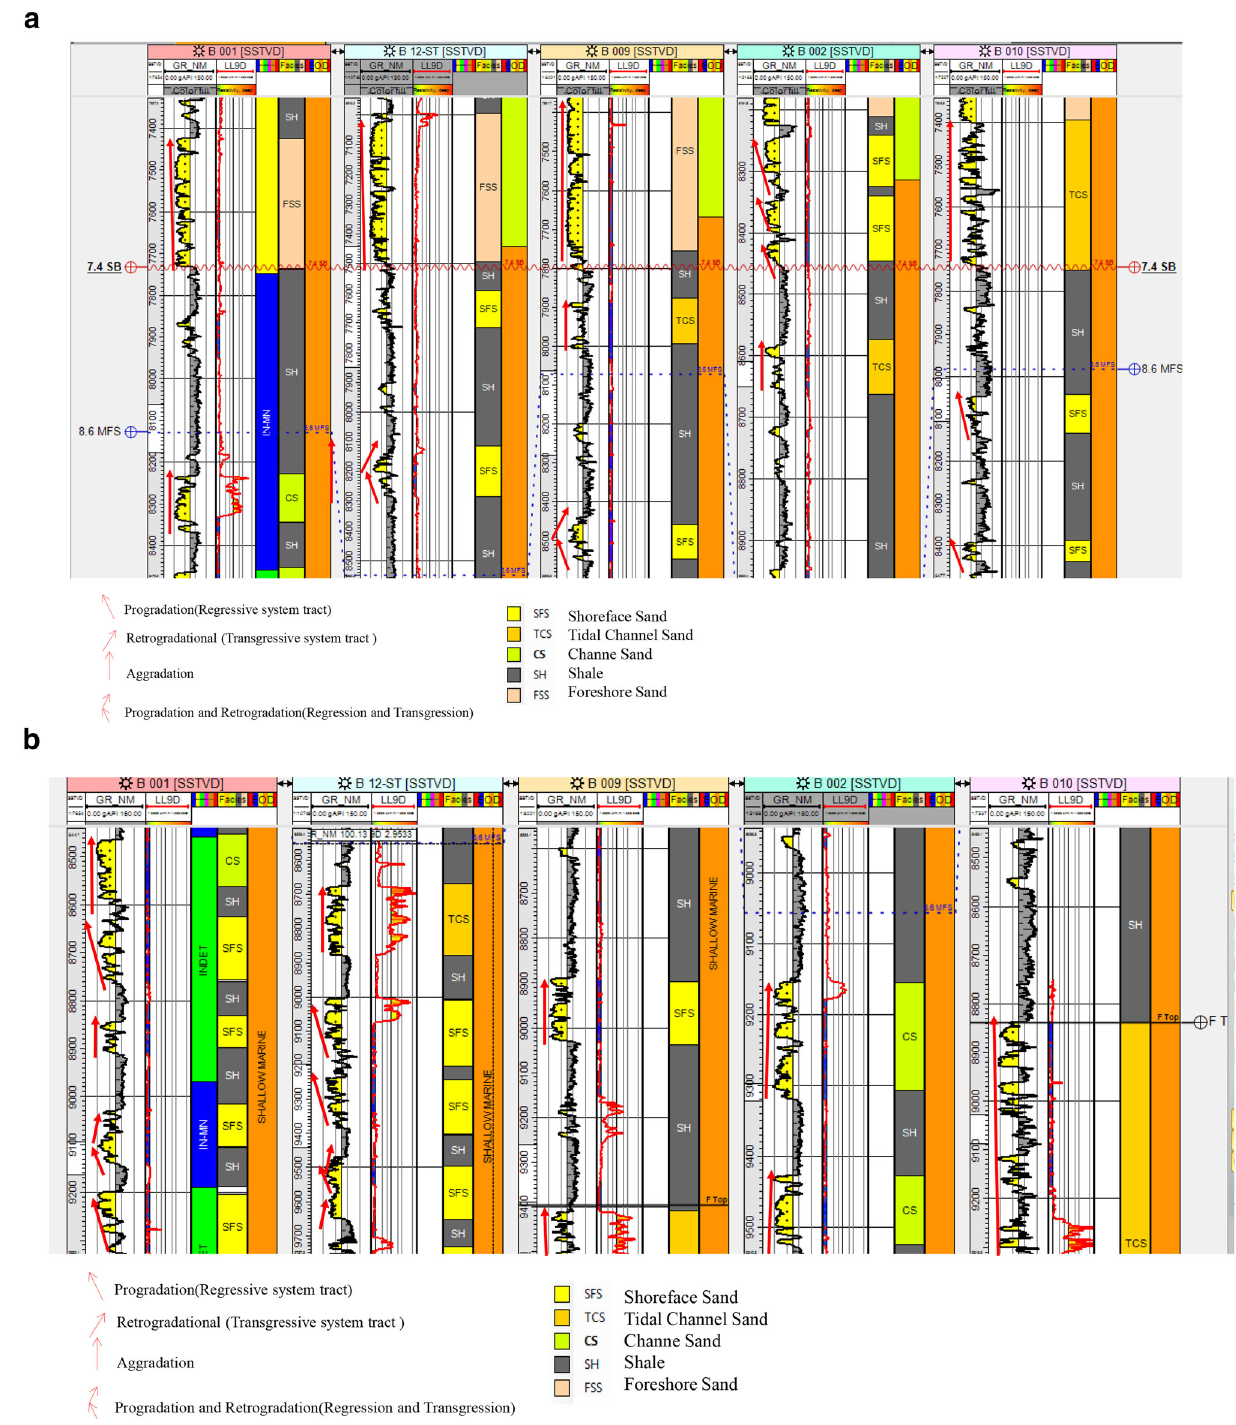
Fig. 3 Depositional environment discrminations of the a 7500–8500 ft interval, b 8500-9300 ft interval, c 9600–10,300 ft interval and d 10,300–11,000 ft interval for the Bruks